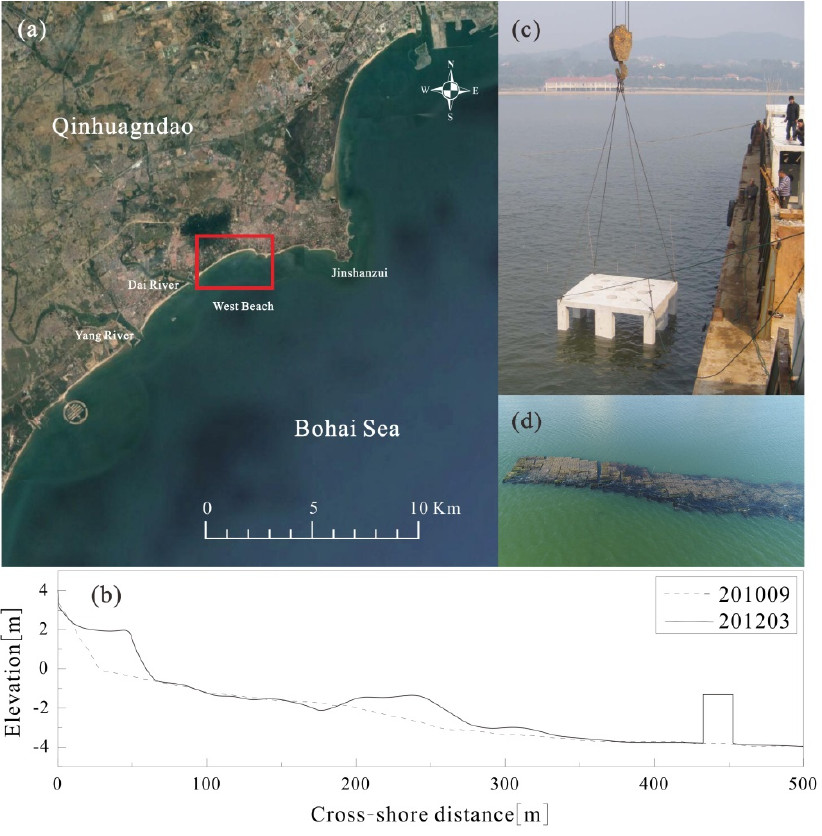
Figure 1. The application of AR in the beach nourishment project of West Beach in Qinhuangdao, China: ( a ) geographical location; ( b ) typical profiles before (201009) and after the project (201203); ( c ) the construction of AR; ( d ) AR at the lowest tide.